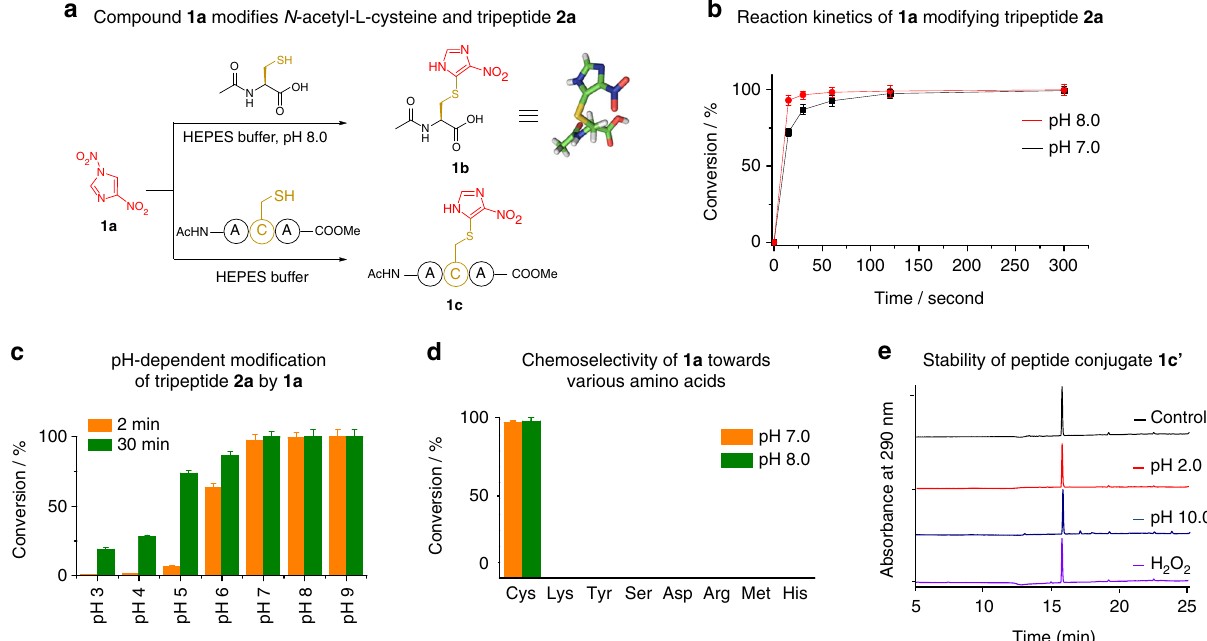
Fig. 2 Compound 1a modi fi es cysteine thiol with high ef fi ciency and speci fi city by generating stable conjugates. a Reaction of compound 1a with cysteine and tripeptide 2a . The CCDC reference number of compound 1b is 1860451. b Reaction kinetics of compound 1a (0.2 mM) with tripeptide 2a (0.1 mM) at pH 7.0 and 8.0. c The reaction between of 1a (0.2 mM) and 2a (0.1 mM) under various pH for 2 min and 30 min. d Reactions of compound 1a (0.2 mM) with nucleophilic amino acids (0.1 mM) for 15 min under pH 7.0 and 8.0. e Chemical stability of the tripeptide-(4-nitroimidazole) conjugate 1c' at pH 2.0, pH 10.0, and under oxidative conditions (10 mM H 2 O 2 in Na 2 CO 3 buffer at pH 8.0) at 37 °C for 10 h. The conversion values represent means±